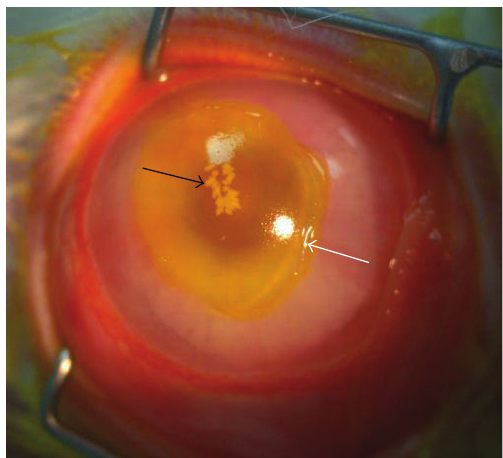
Figure 3: Staphylococcus keratitis in the New Zealand white rabbit 19 hours after infection. Experimental keratitis was induced by intracorneal injection of 100 colony-forming units of methicillin- resistant S. aureus (clinical blood specimen) according to the method of O’Callaghan’s group [18]. The black arrow indicates the presence of stromal infiltration, and the white arrow indicates the edge of a large corneal epithelial erosion, which was stained with fluorescein for ease of